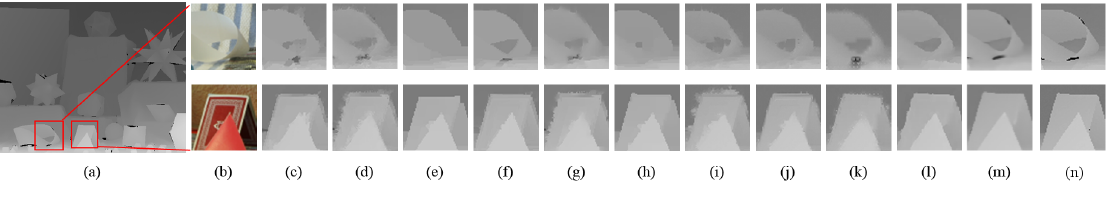
Figure 7. Example depth map SR results of Moebius with two ROI. ( a ) Ground truth depth map, ( b ) color regions, and SR results of ( c ) Diebel et al. [22] (BP% = 9.58) , ( d ) JBU [11] (6.48) , ( e ) Lu et al. [23] (6.36) , ( f ) Kim et al. [24] (5.46) , ( g ) Jung [17] (6.03) , ( h ) Lo et al. [3] (4.33) , ( i ) Park et al. [26] (6.49) , ( j ) Ferstl et al. [27] (3.53) , ( k ) Choi et al. [18] (4.97) , ( l ) Lo et al. [21] (3.04) , ( m ) Our method (1.53) , and ( n ) the associated ground truth.